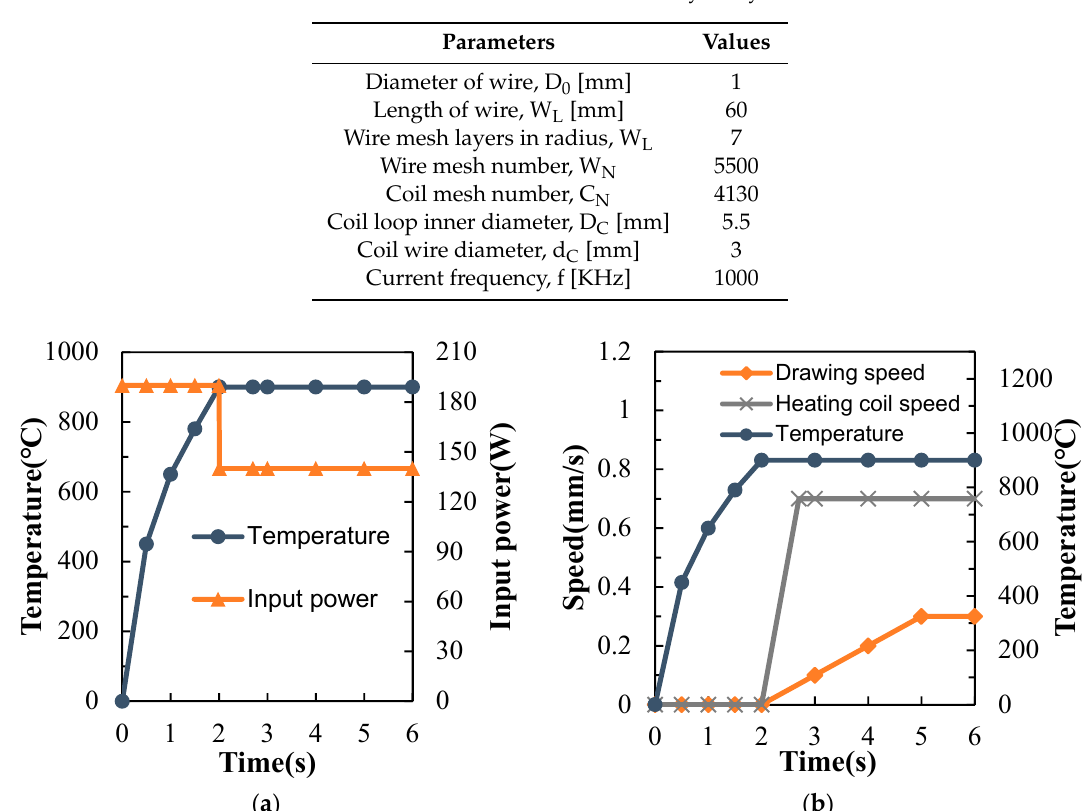
Table 2. Parameters used in formability analysis.